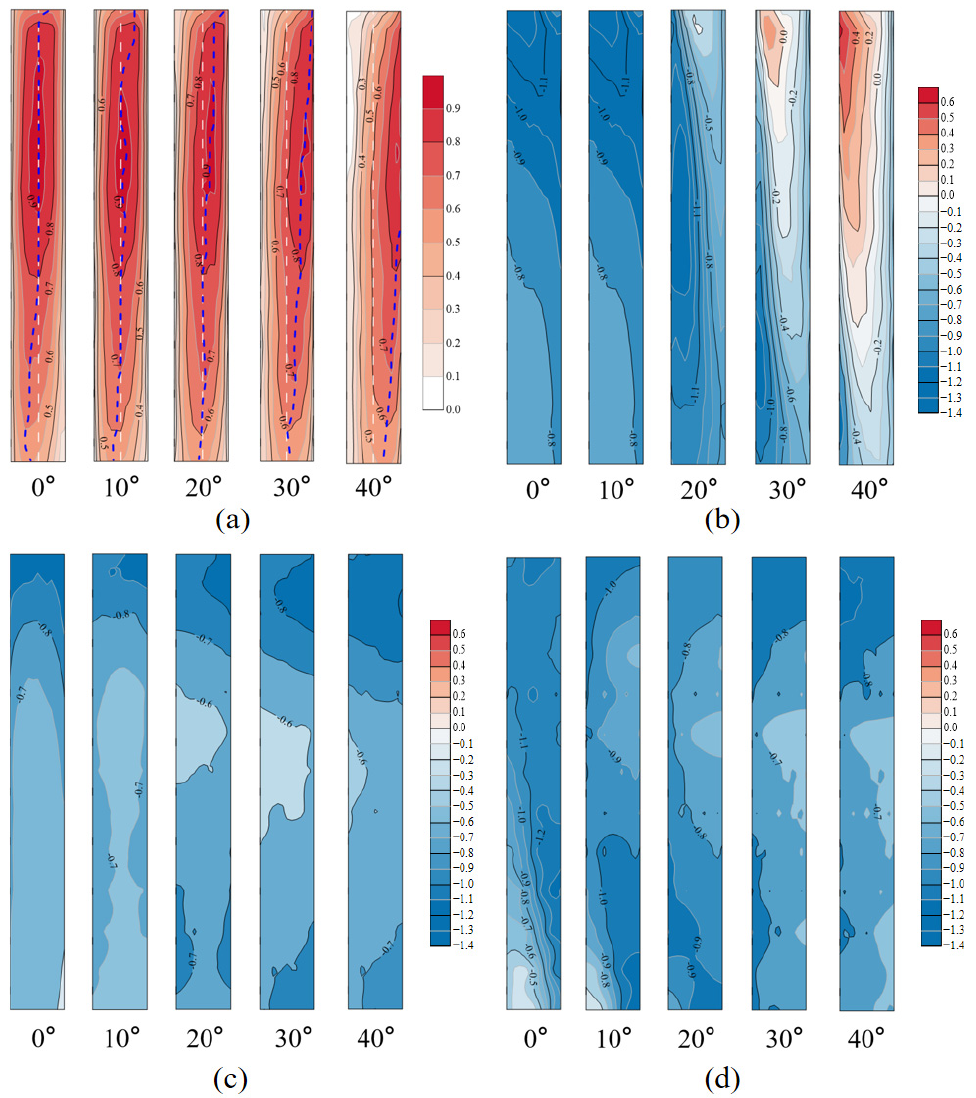
Figure 7. Distributions of C p in TWF30: ( a ) Windward facade; ( b ) Right facade; ( c ) Leeward facade; and ( d ) Left facade.